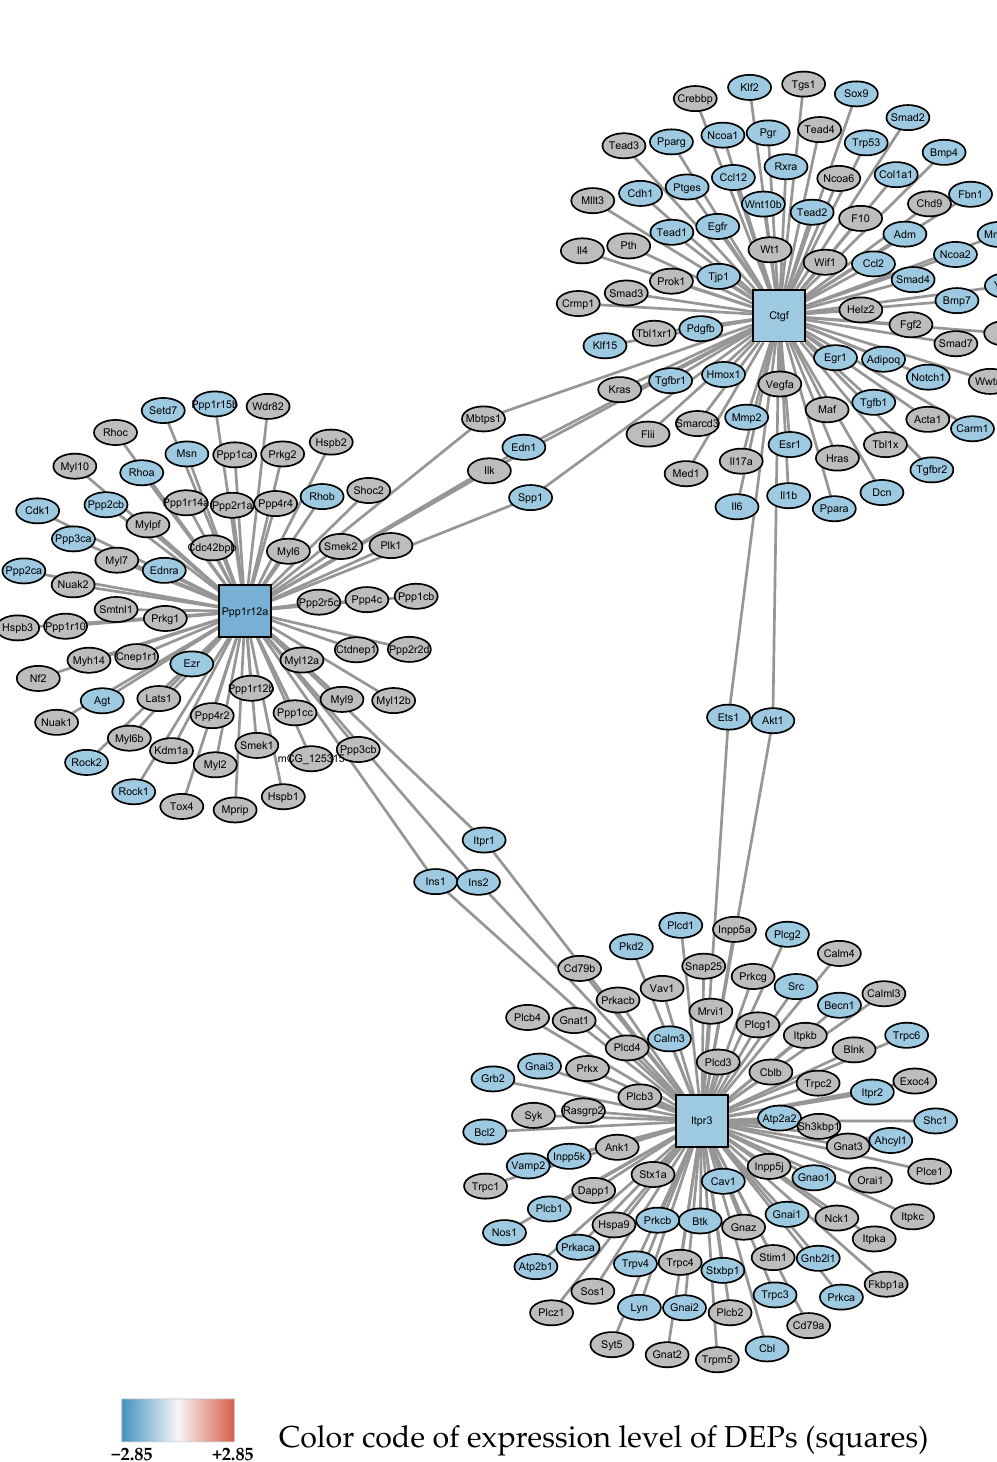
Figure 3. Subnetwork 1 of functionally associated DEPs and their interaction partners after 24 h exposure to 0–95% O 2 oscillations. Blue square nodes are seed proteins found to be downregulated. The most significant enriched pathway associated with the interacting proteins with FDR < 0.05 is shown as blue ellipses and represents: “response to oxygen-containing compound”. After 72 h, 0–95% O 2 oscillations, 4 proteins were found to be downregulated and 5 proteins were upregulated (see Table 2B). DEPs showed functional relationship in 4 sub- networks. Subnetwork 1 showing nodes and first neighbors is depicted in Figure